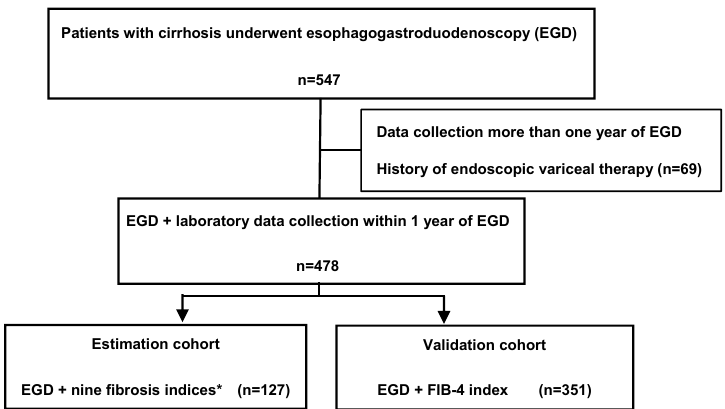
Figure 1. Flow chart showing the division of patients into the estimation and validation cohorts. A total of 547 patients were identified in the database of patients with cirrhosis treated during the study period. After the exclusion of patients with cirrhosis who did not undergo laboratory tests within one year of esophagogastroduodenoscopy (EGD) and those with a history of endoscopic variceal therapy, the remaining 478 patients were divided into the estimation and validation groups. The estimation